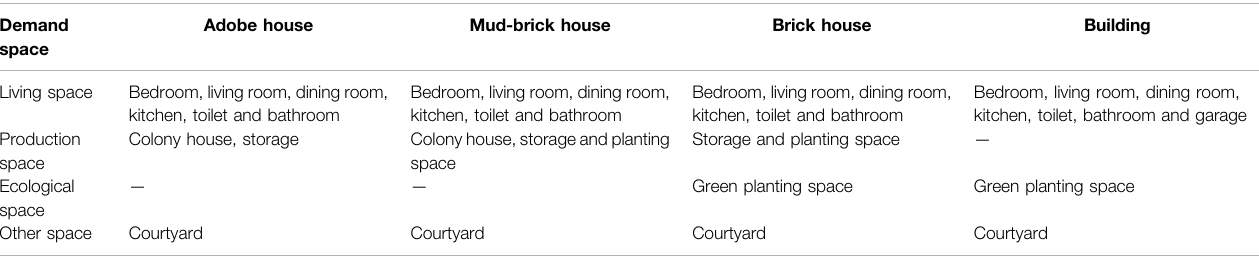
TABLE 3 | Differences in the internal space demands of rural homesteads in different